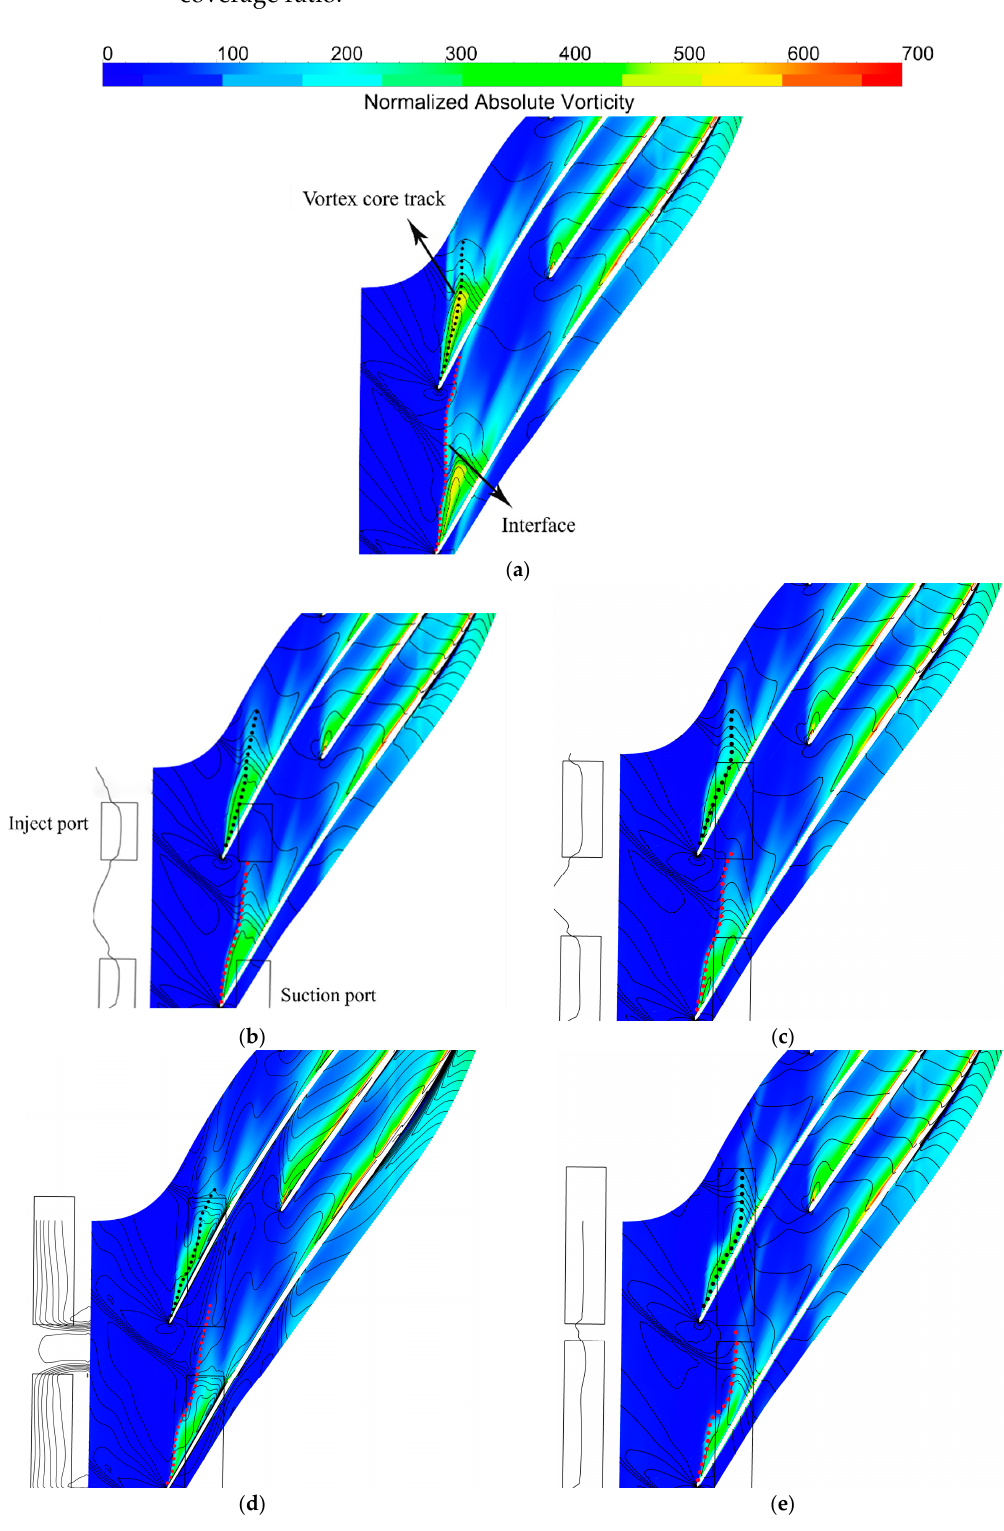
Figure 18. Contours of absolute vorticity and static pressure distributions at 98% blade span. ( a ) SW. ( b ) SRCC0.36. ( c ) SRCC0.54. ( d ) SRCC0.72. ( e ) SRCC0.9. The relative blockage area distribution curves along the axial direction were gener- ated to quantitatively evaluate the improvements in blockage in the blade tip passage by